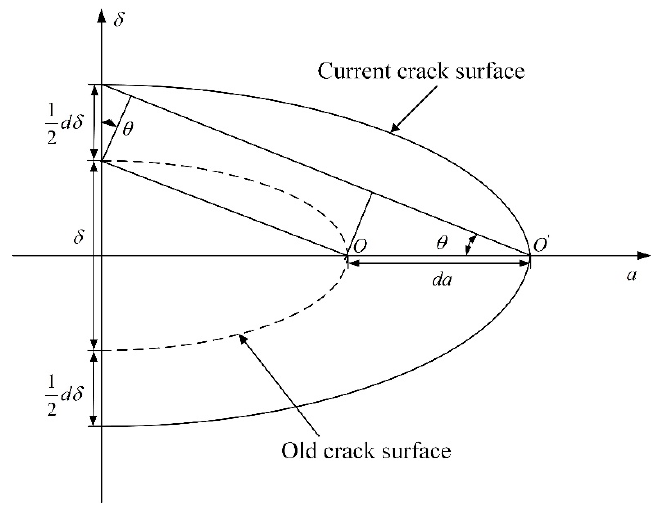
Figure 1. Schematic illustration of crack tip geometry.